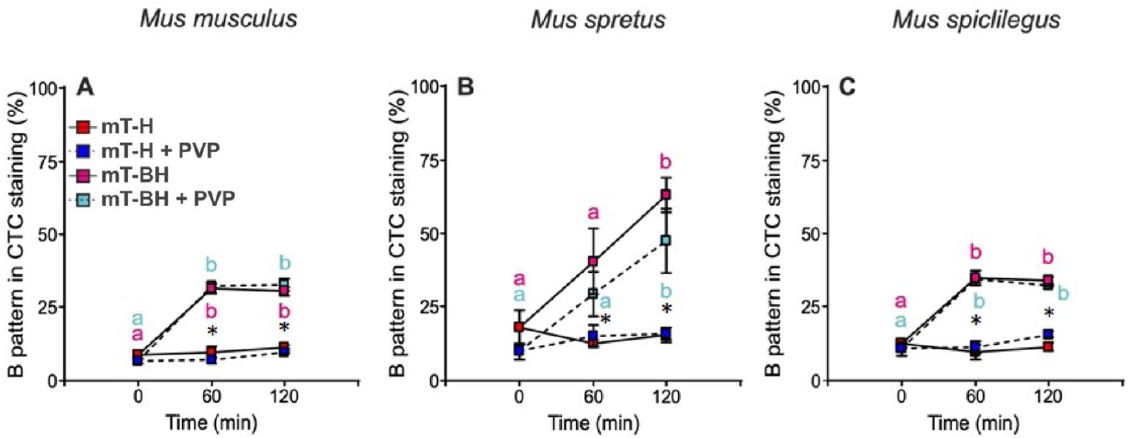
Figure 1. Percentage of spermatozoa exhibiting pattern B after CTC staining in the spermatozoa of three mouse species ( M. musculus , M. spretus , and M. spicilegus ) over time when incubated in mT-H, mT-H + PVP, mT-BH, and mT-BH + PVP. Data are means ± SE ( M. musculus : N = 4; M. spretus : N = 5; M. spicilegus : N = 4). ( A ), M. musculus . ( B ), M. spretus . ( C ), M. spicilegus . Red squares: non-capacitating conditions with low viscosity, mT − H medium under air. Pink squares and letters: capacitating conditions with high viscosity, mT − BH + PVP medium under air. Dark blue squares: non-capacitating conditions with low viscosity, mT − BH medium under 5% CO 2 /air. Light blue squares and letters: capacitating conditions with high viscosity, mT − BH + PVP under 5% CO 2 /air. Different letters indicate significant differences between times for the same treatment in a Fisher post-hoc test ( p < 0.05). Asterisks indicate significant differences between non-capacitating and capacitating conditions ( p < 0.0001). There were no differences associated with the viscosity of the medium in non-capacitating or capacitating conditions.